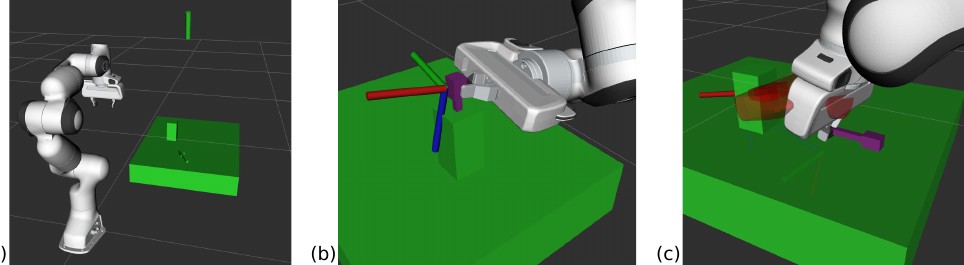
Figure 4. Experimental setup used for evaluation: ( a ) scene setup with the robot, object camera, and table, ( b ) planned grasps which do not result in collisions are evaluated as successful, ( c ) grasps that result in collisions between the robot and the table are evaluated as